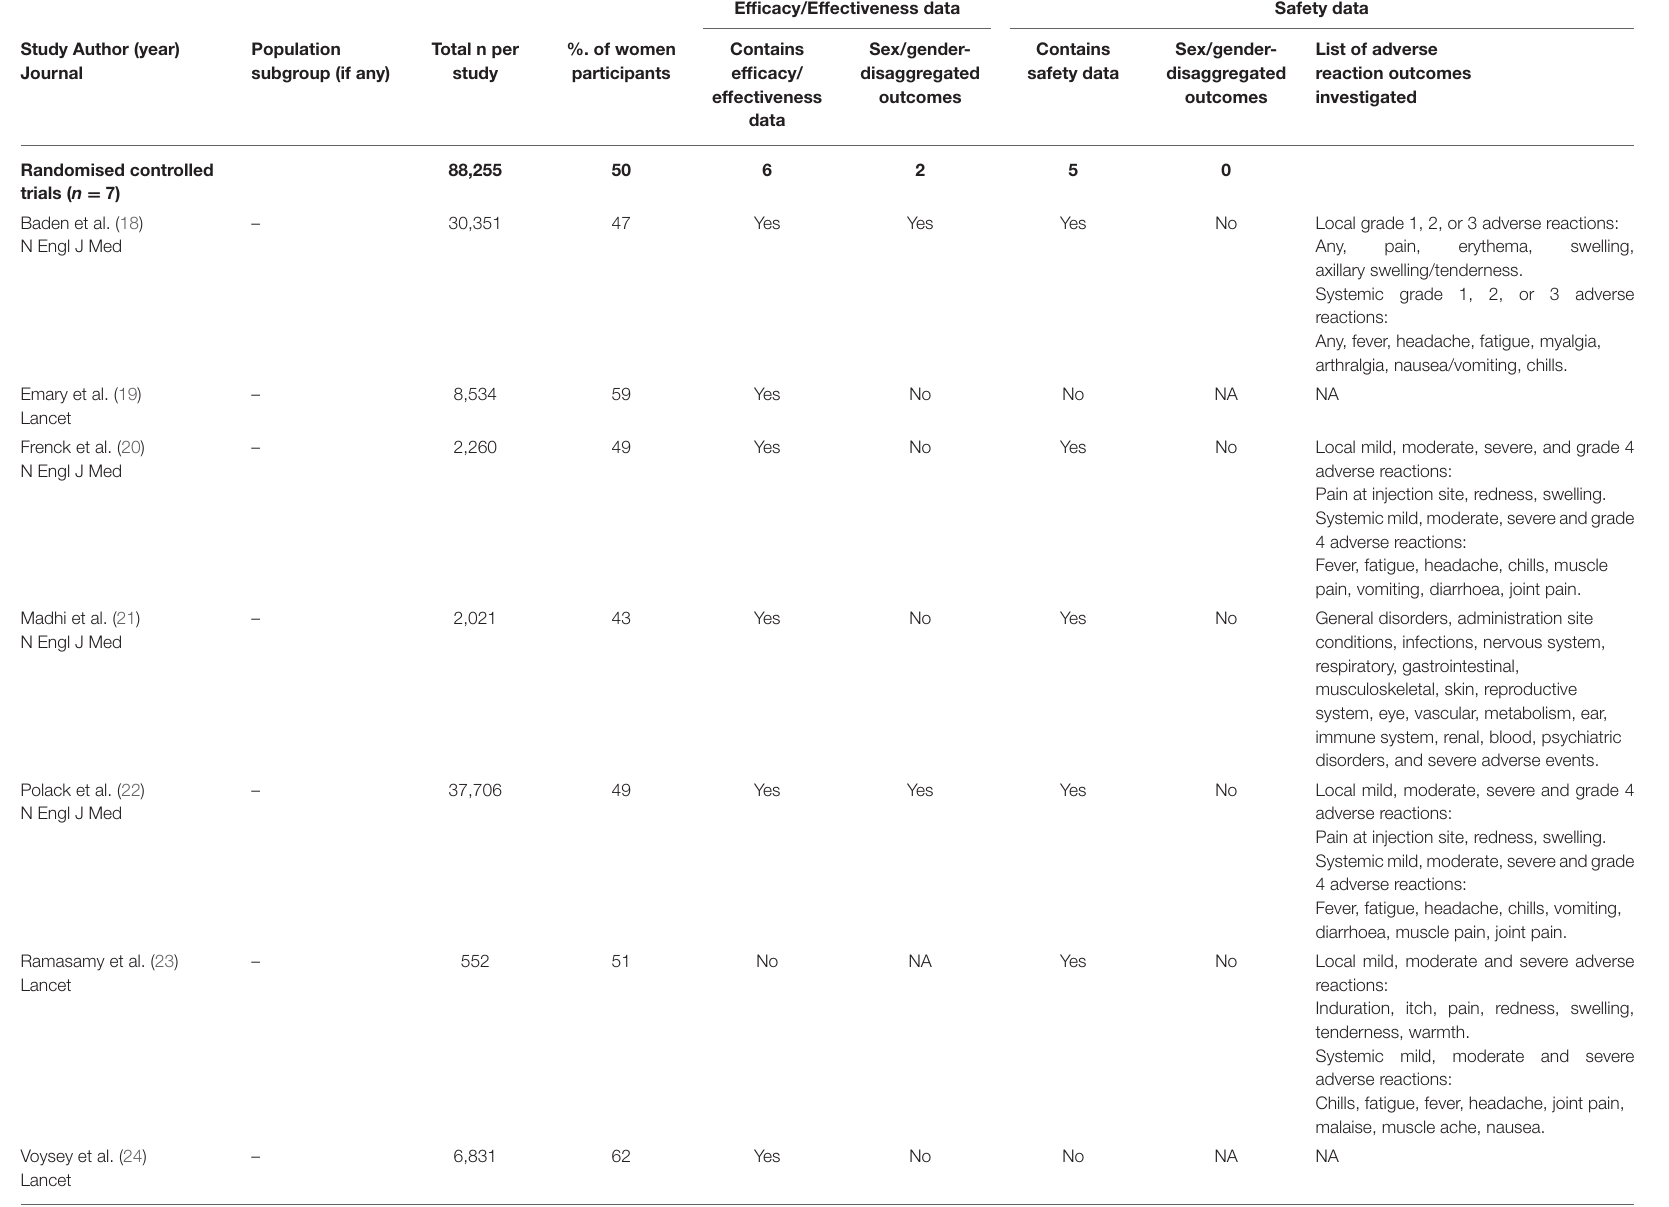
TABLE 1 | Description of studies and their inclusion of sex/gender-disaggregated